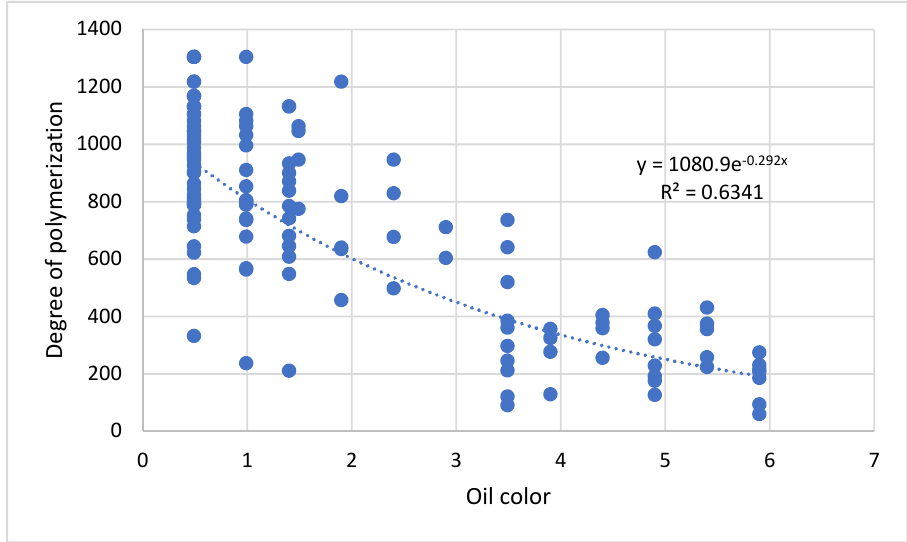
Figure 5. Exponential relationship between DP and OC.